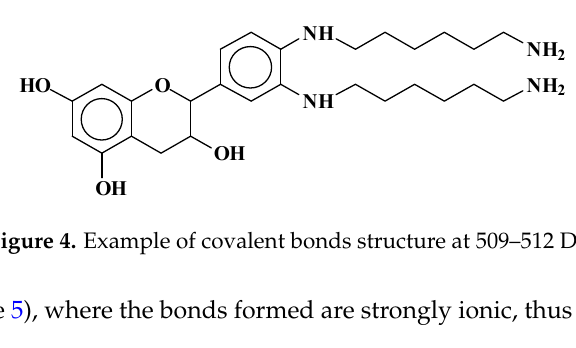
Figure 3. MALDI-ToF spectrum of the reaction of catechin with hexamethylene diamine at 185 °C, NaOH-catalysed. Range 600–1500 Da.